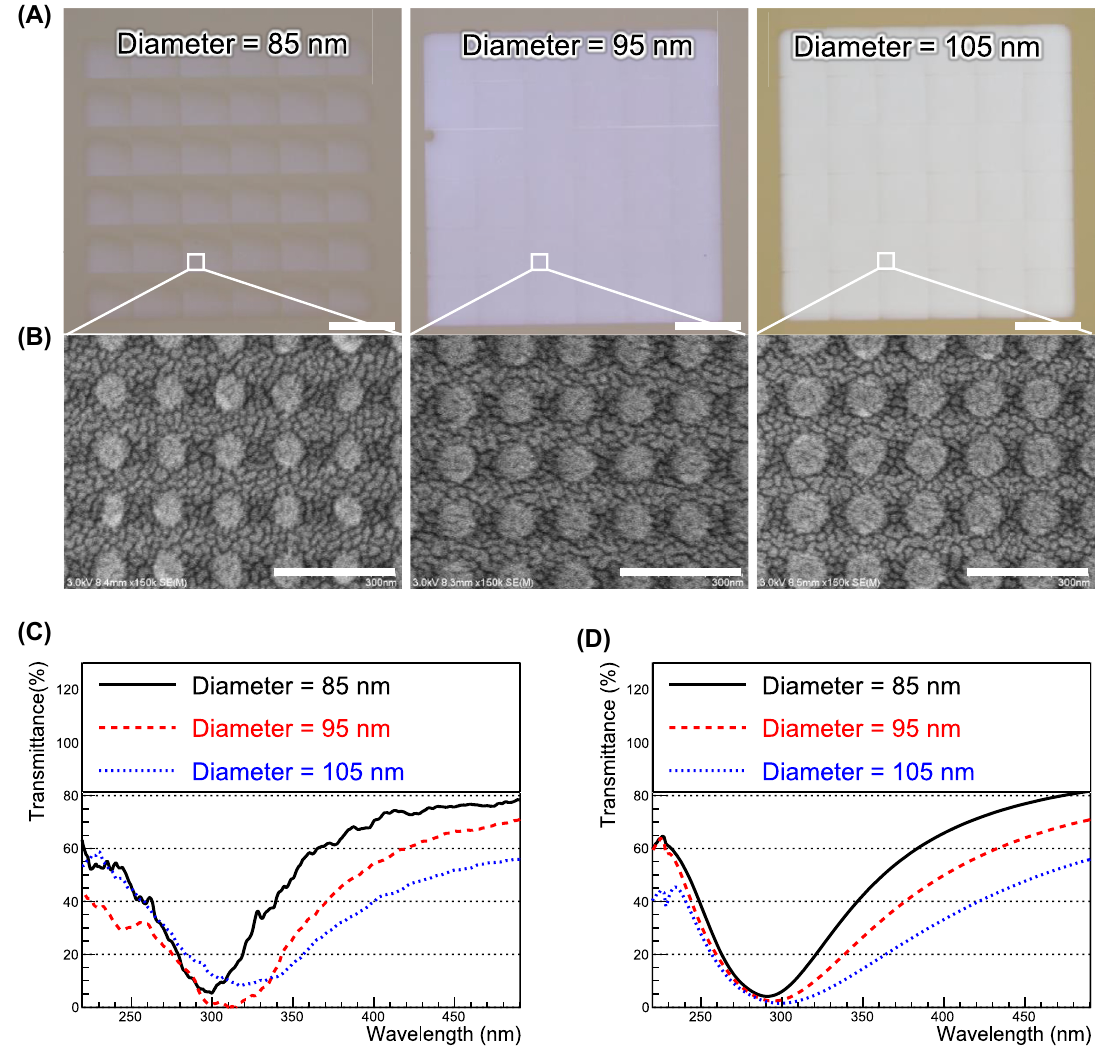
Figure 2: Microscopic images of fabricated plasmonic filters, and their experimental and simulations results. (A) Microscopic images of aluminum nanodisks of different diameters (85, 95, and 105 nm). Scale bar is 200 μ m. (B) SEM images of aluminum nanodisks of different diameters (85, 95, and 105 nm). Scale bar is 300 nm. (C) and (D) Transmission spectra of aluminum nanodisks of different diameters (85, 95, and 105 nm) for experiments and simulations,